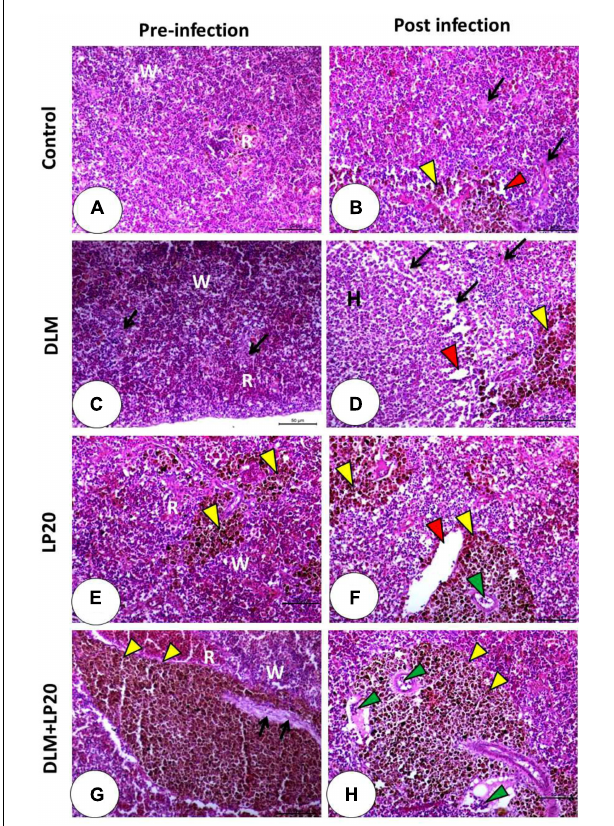
FIGURE 9 | Histomicrograph of the spleen of Nile tilapia subjected to four treatments (control, DLM, LP20, and DLM + LP20) before (A,C,E,G) and after (B,D,F,H) infection. The control group (A) shows normal architecture of red (R) and white (W) bulbs and normal blood sinusoids, while the post-infected group (B) shows degenerated cells (black arrow), dilated blood sinusoids (red arrowhead), and melanomacrophages (yellow arrowhead). DLM (C) shows distributed degeneration (black arrow) in both white and red bulbs, while the post-infected DLM group (D) shows degeneration (black arrow), dilated blood sinusoids (red arrowhead), and melanomacrophage center. LP20 (E) shows normal architecture with distributed melanomacrophage centers (yellow arrowhead), while the post-infected group (F) shows normal red and white bulbs with dilated blood vessels (red arrowhead) and leukocytic infiltration (green arrowhead). LP20 added with DLM (G) shows increased melanomacrophage centers (yellow arrowhead) and slight degeneration (black arrow), while the post-infected group shows leukocytic infiltration (green arrowhead) besides the increased melanomacrophage centers (yellow arrowhead). Stain H&E. Bar = 100 µ